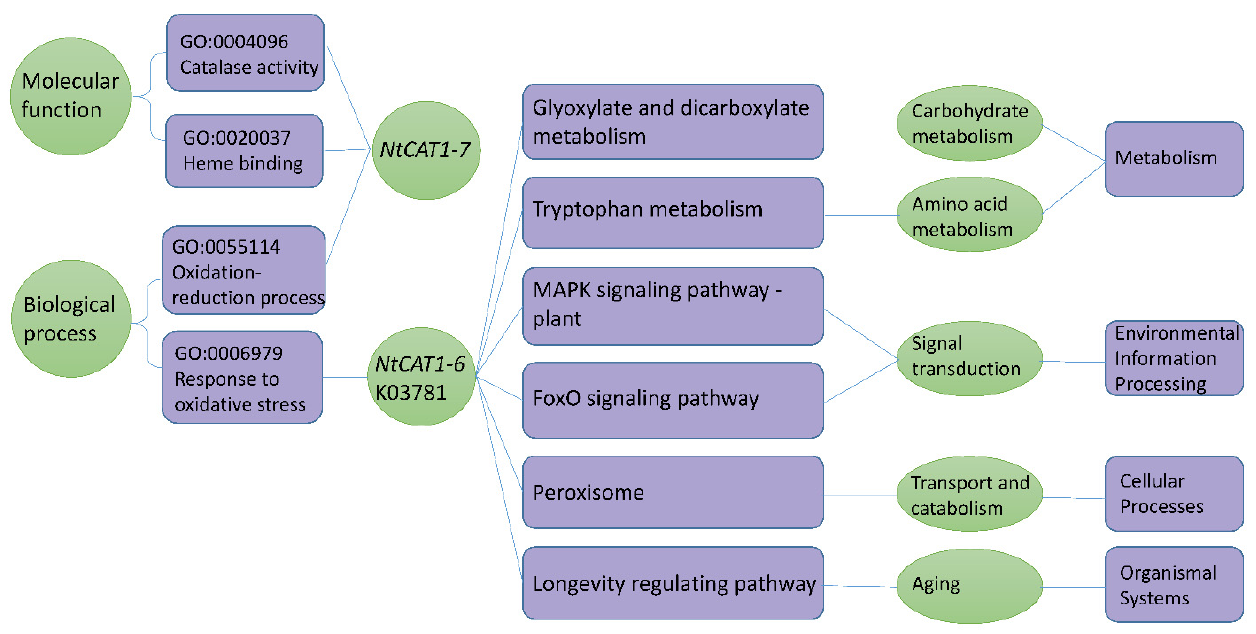
Figure 5. Function annotation of NtCATs based on Gene Ontology (GO) and KEGG pathways.